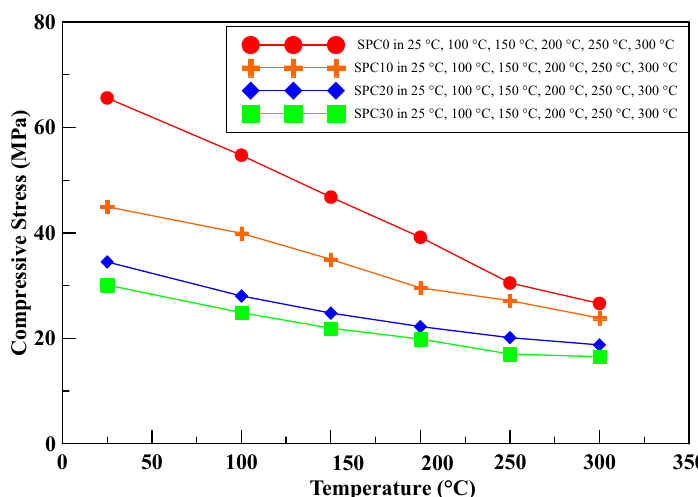
Figure 9. The maximum compressive strength of the specimens with various perlite ratios at different elevated temperatures.